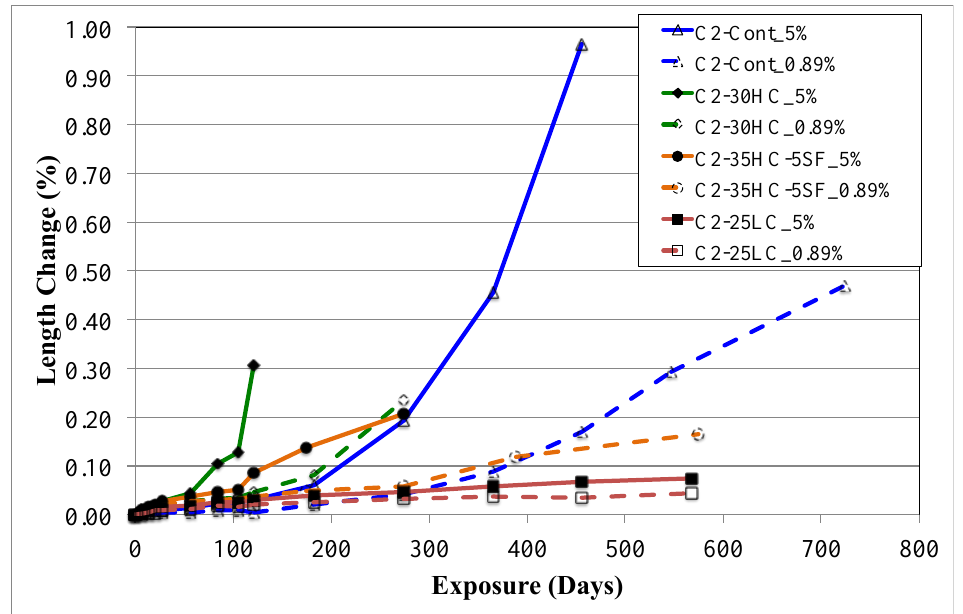
Figure 3. Accelerated mortar bar expansion results for Type I/II mixtures exposed to 5 and 0.89% Na 2 SO 4 .